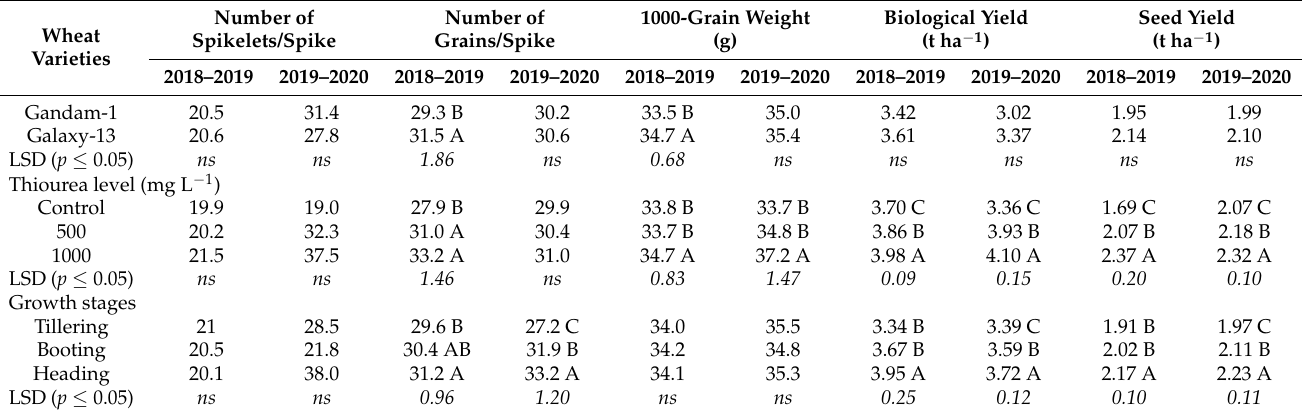
Values sharing same letter in each factor treatments are statistically similar; ns —not